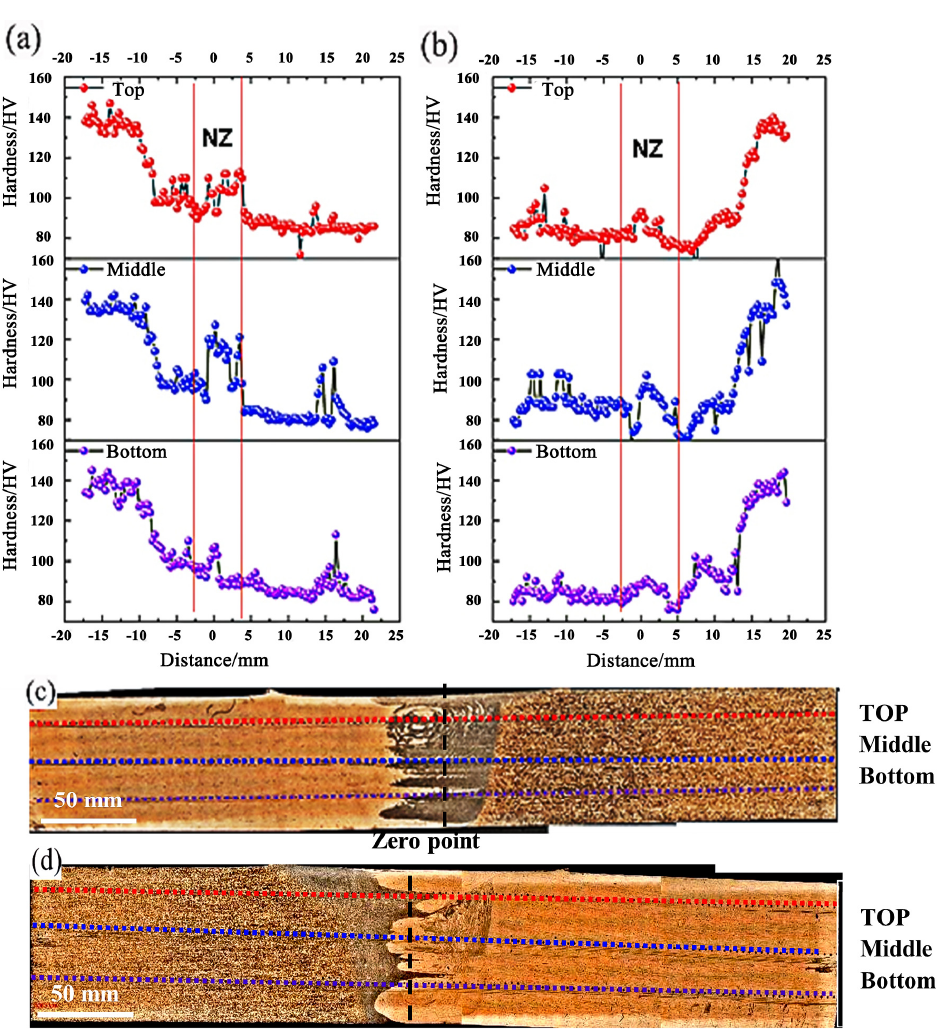
Figure 6. Microhardness distribution of cross section of welded joint ( a , c ) 2A5R, ( b , d ) 5A2R.